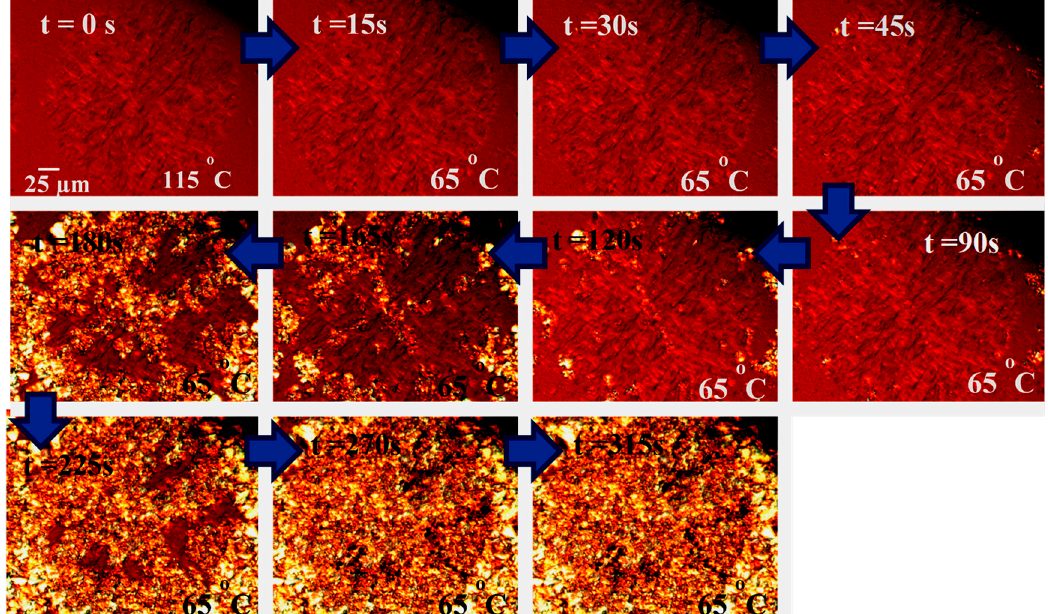
Figure 3. PBS crystallization at 65 °C from a PLLA spherulite ( T c = 115 °C) within a LL 205.4 - mb -BS 807.4